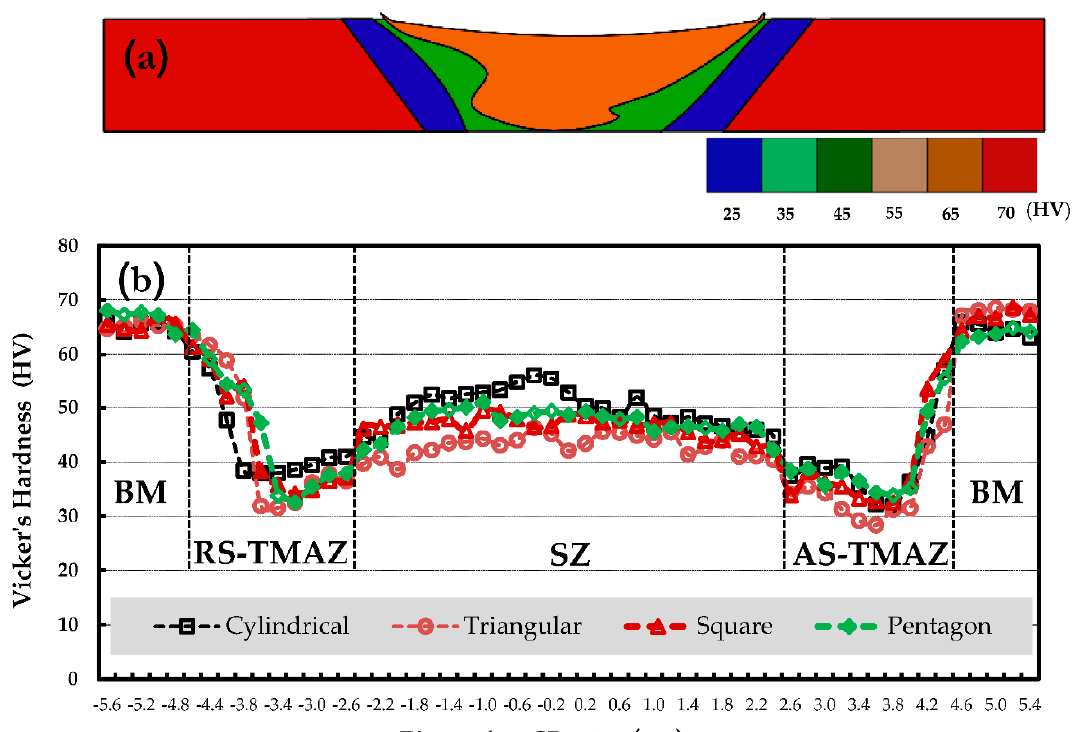
Figure 7. Vicker’s hardness profiles: ( a ) Vicker’s hardness profiles in the cross-section of the welded on FSWp of SSM 6063 aluminum alloys and ( b ) Plot graph between Vicker’s hardness profiles and Distance from SZ center.